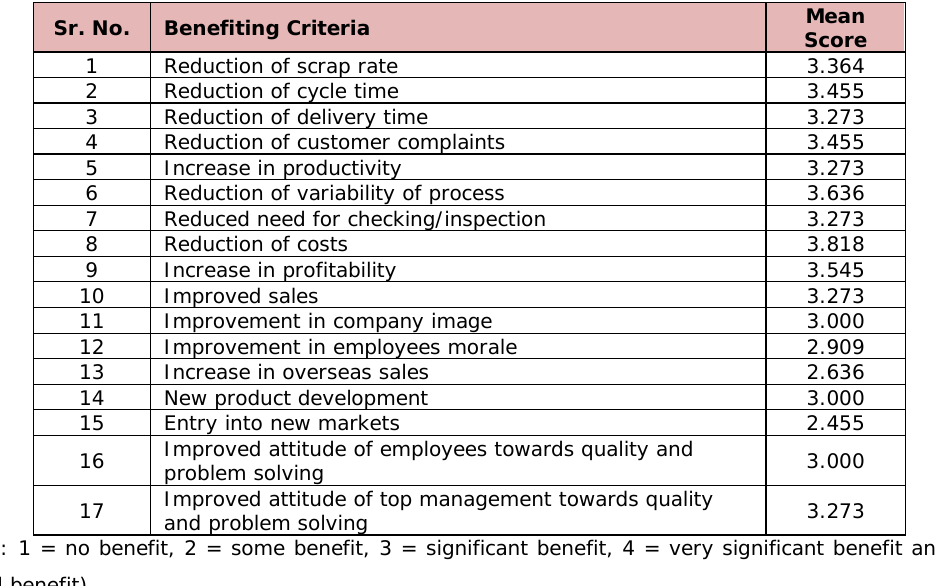
Table 1. “Benefits of Six Sigma programme to Indian industries – General